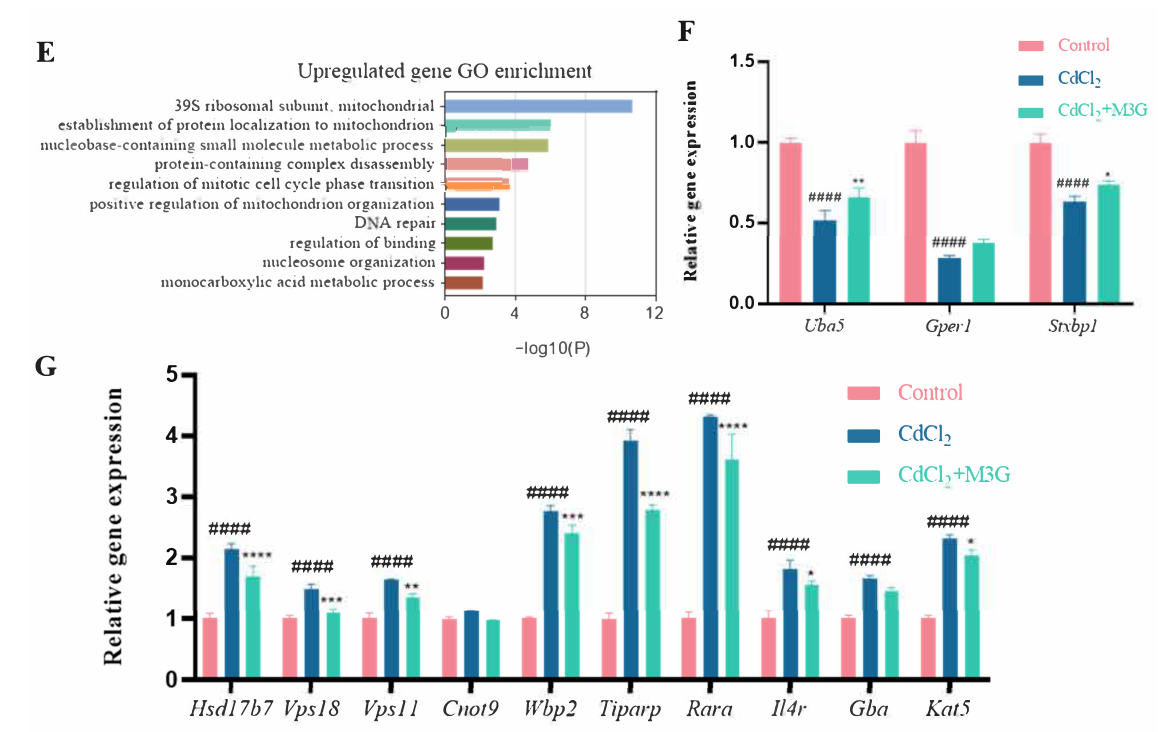
Figure 5. Transcriptome after CdCl 2 treatment alone and in combination with M3G. RNA sequencing and bioinformatics analysis of KGN cells following treatment with 10 µ mol/L CdCl 2 and 200 µ mol/L M3G separately or in combination: ( A ) differential gene volcanic maps; ( B ) the PCA analysis results; ( C ) hierarchical clustering heat map of differentially expressed genes; ( D,E ) GO classification of differ- entially expressed enrichment; Estrogen-sensitive genes selected from the RNA sequencing analysis; ( F ) the upregulated gene expression after CdCl 2 + M3G treatment; and ( G ) the downregulated gene expression after CdCl 2 + M3G treatment. Mean ± SD, n = 3. #### p < 0.0001, vs. control; * p < 0.05,